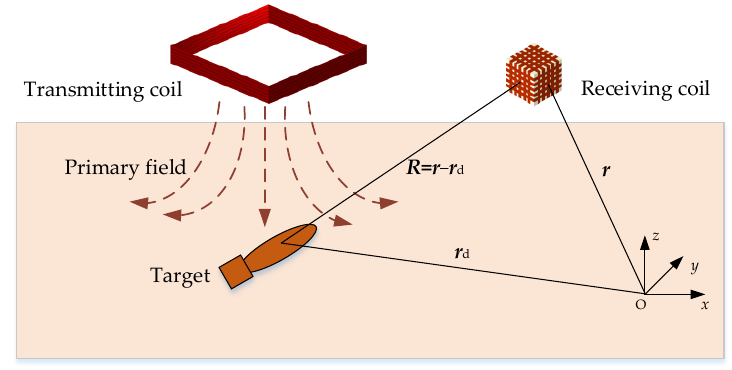
Figure 5. Principle of target detection based on a single dipole model.